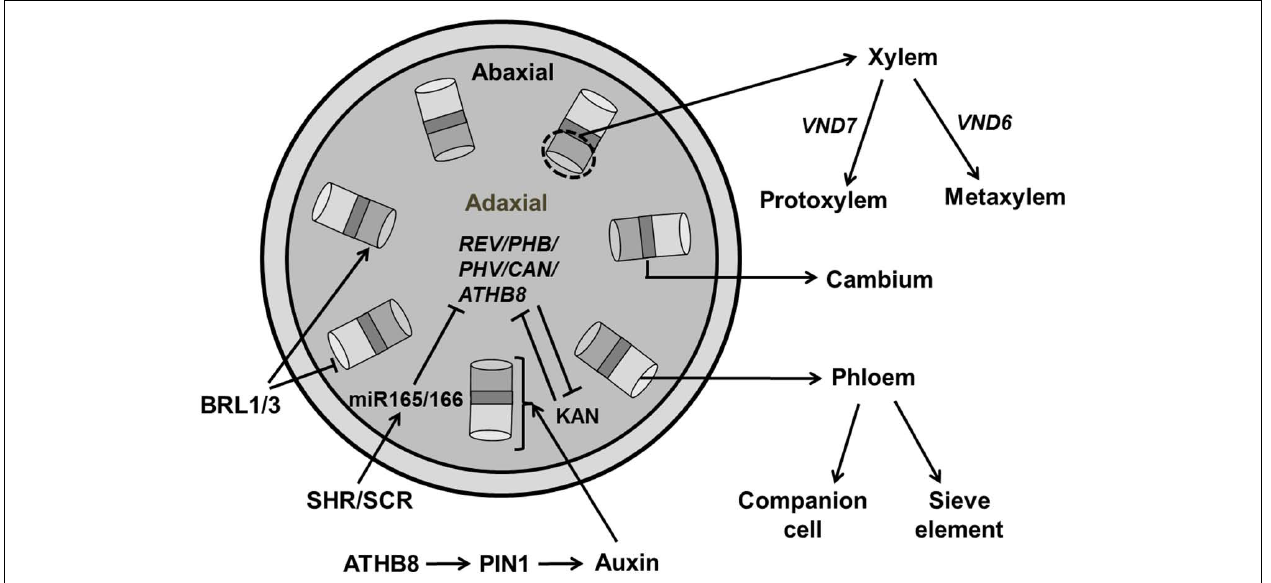
FIGURE 11 | Regulation of vascular development. Central regulators for vascular development involves the REV/PHB/PHV/CAN/ATHB8 genes which are members of HD-ZIP III family and KAN (KANADI). These regulators act antagonistically to maintain xylem and phloem, respectively. Transcription factors, SHR (SHORT ROOT) and SCR (SCARECROW) activate miR165/166, which further inhibits HD-ZIP III. Auxin plays an